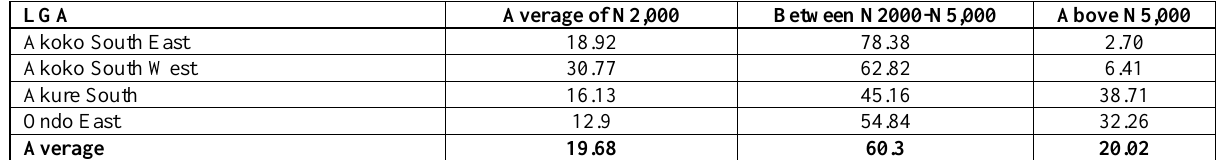
Table 4. Distribution of Monthly bills under old Meter System in